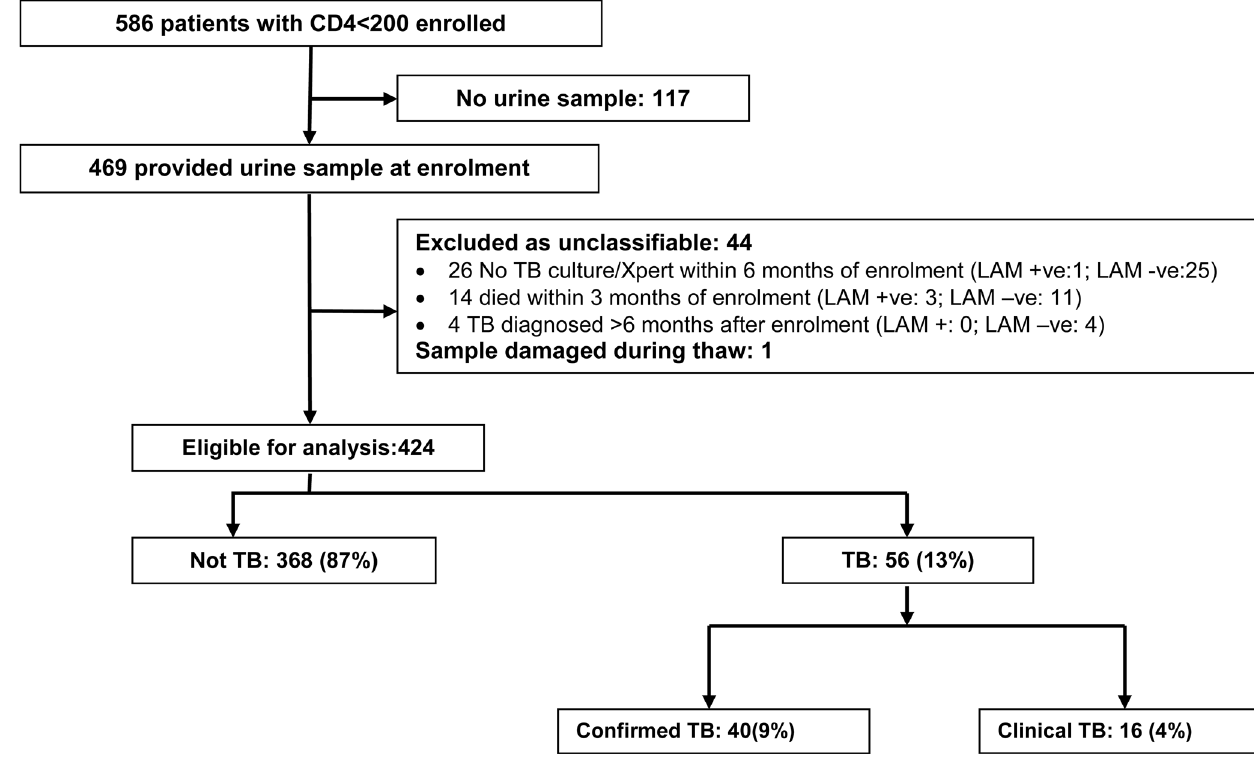
Fig 2. Flow chart of study participants. LAM+ defined as (cid:1) grade 1.